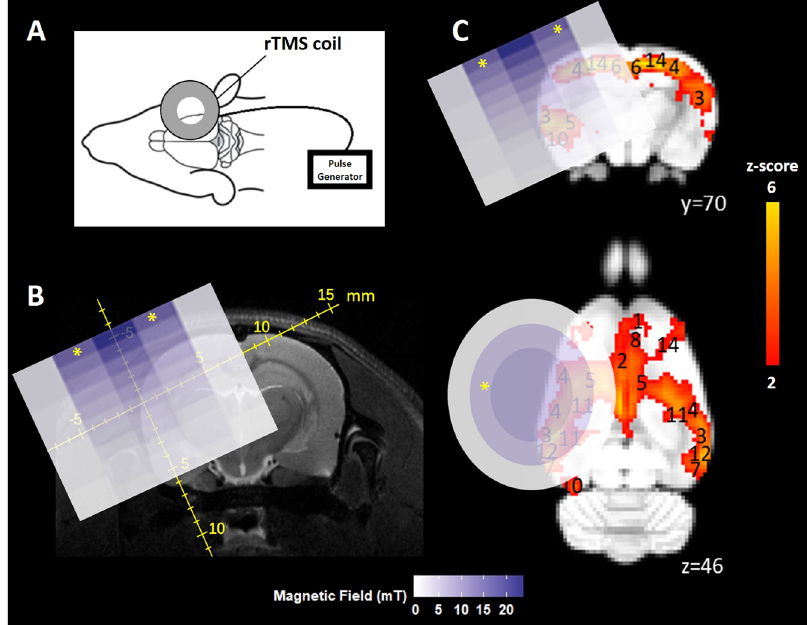
Figure 5. Coil position and magnetic field. ( A ) Coil position relative to rat head and brain. ( B ) 2D representation of the magnetic field induced by the LI-rTMS coil superimposed on a representative raw T2- weighted brain image with scale in mm. Measurements were taken on a hall device at 1 mm increments. ( C ) 2D representation of the magnetic field induced by the LI-rTMS coil superimposed on colour-coded coronal and axial slices for a representative pre-stimulation group-ICA component overlaid on the Sprague Dawley brain template (down-sampled by a factor of eight). White-blue colour bar indicates magnetic field intensities. Yellow-red colour bar indicates z-scores (n = 24, thresholded at z > 2, uncorrected p-value < 0.0455 for a two- tailed hypothesis). x, y, z refer to the coordinates in standard Sprague Dawley template space.“ * ” indicates the zone where electric field is